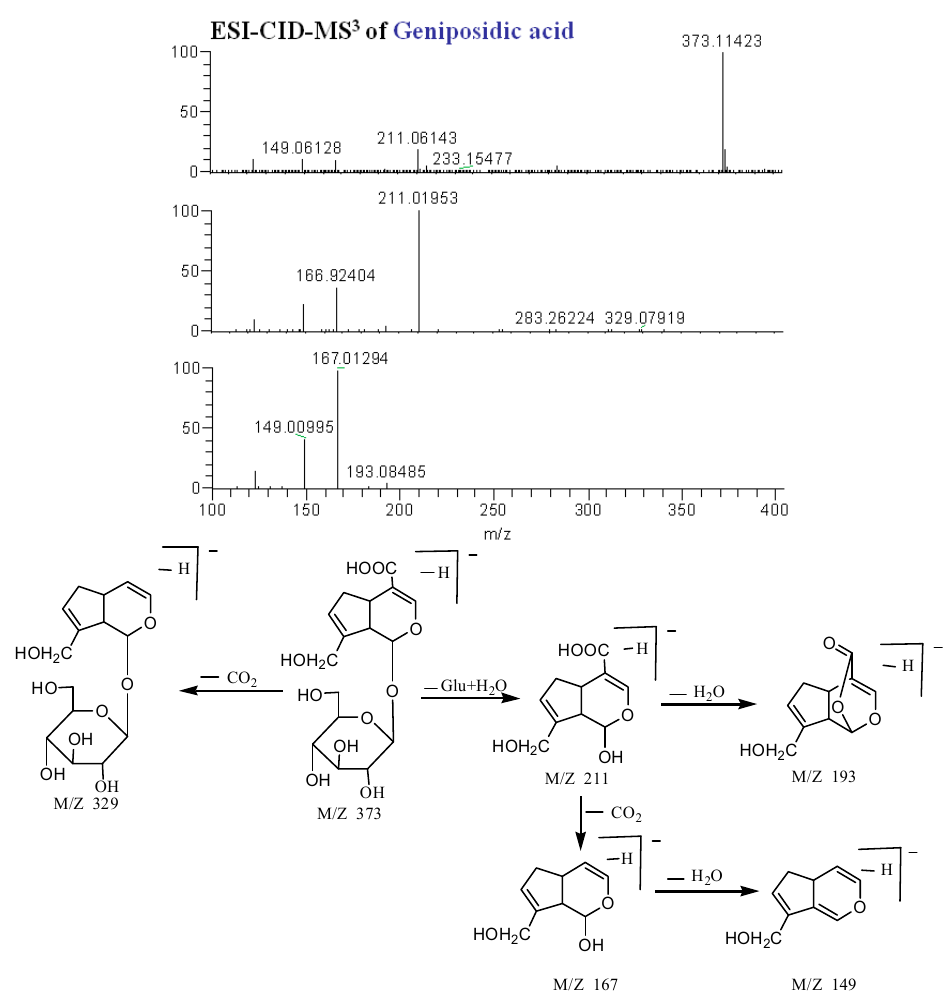
Figure 7. ESI-CID-MS 3 spectra and proposed fragmentations for geniposidic acid ( 16 ) from WZYZW.